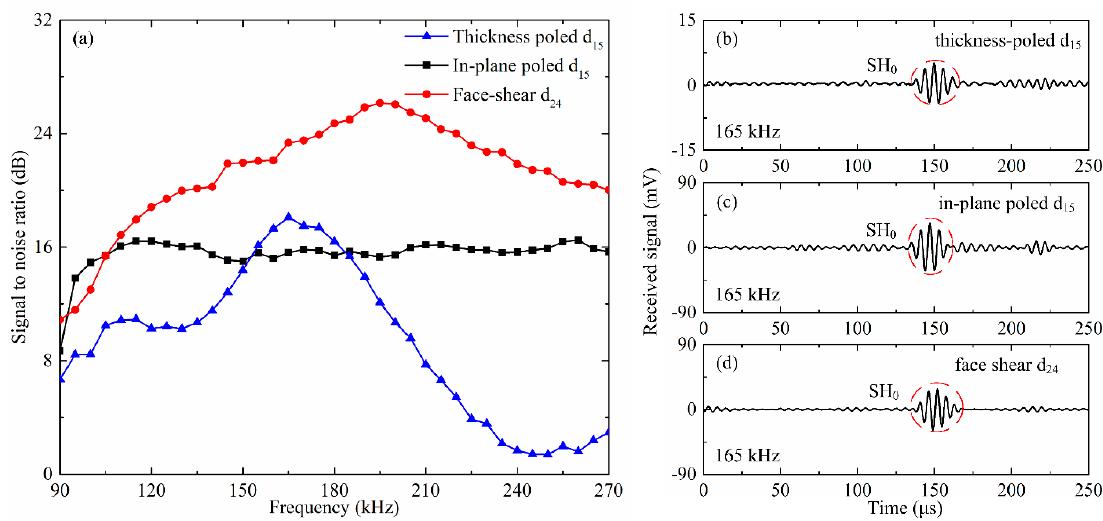
Figure 11. The signal to noise ratio (SNR) of SH 0 wave generated and received by the same type shear mode piezoelectric wafers. ( a ) SNR verses frequency. Wave signals generated by ( b ) in-plane poled d 15 wafer; ( c ) face shear d 24 mode wafer and ( d ) thickness-poled d 15 mode wafer under the drive voltage of 20 V at 165 kHz.